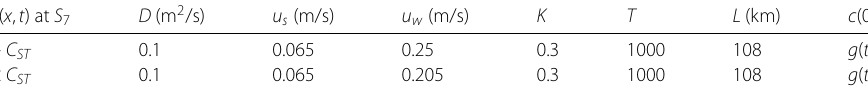
Table 6 Physical parameters of simulation 3 c ( x , t ) at S